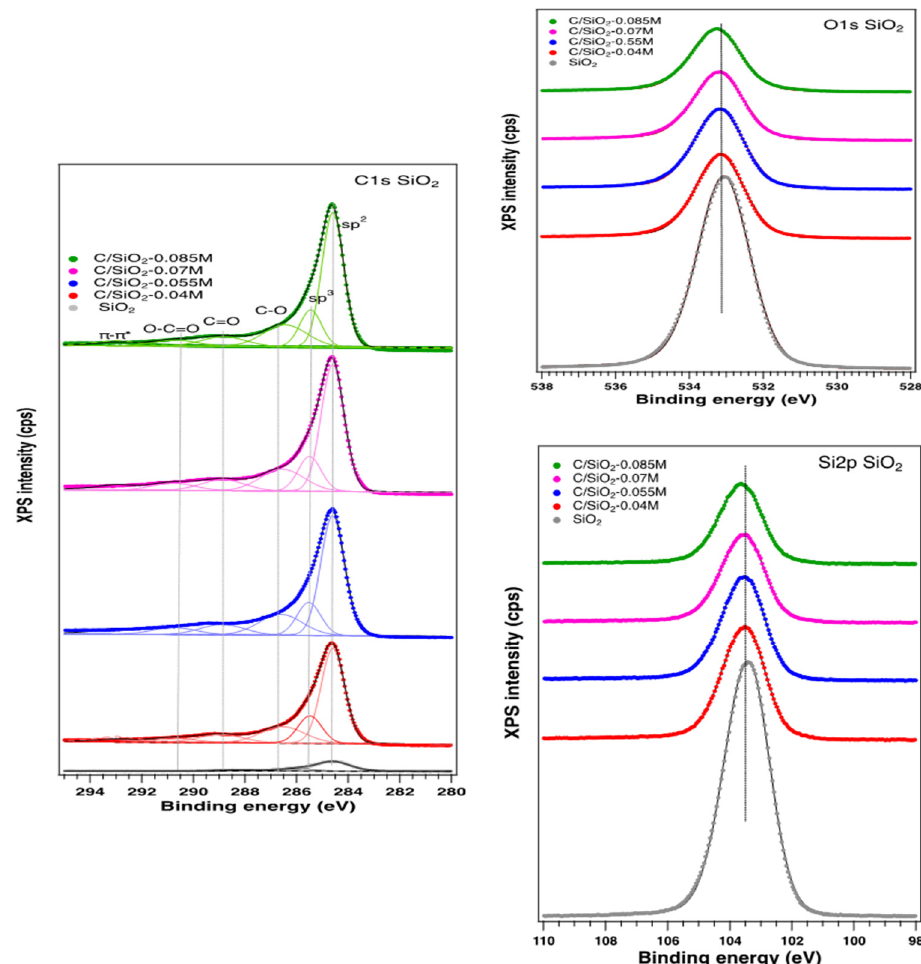
Figure 3. High resolution of C 1s, O 1s, and Si 2p for all the samples prepared.